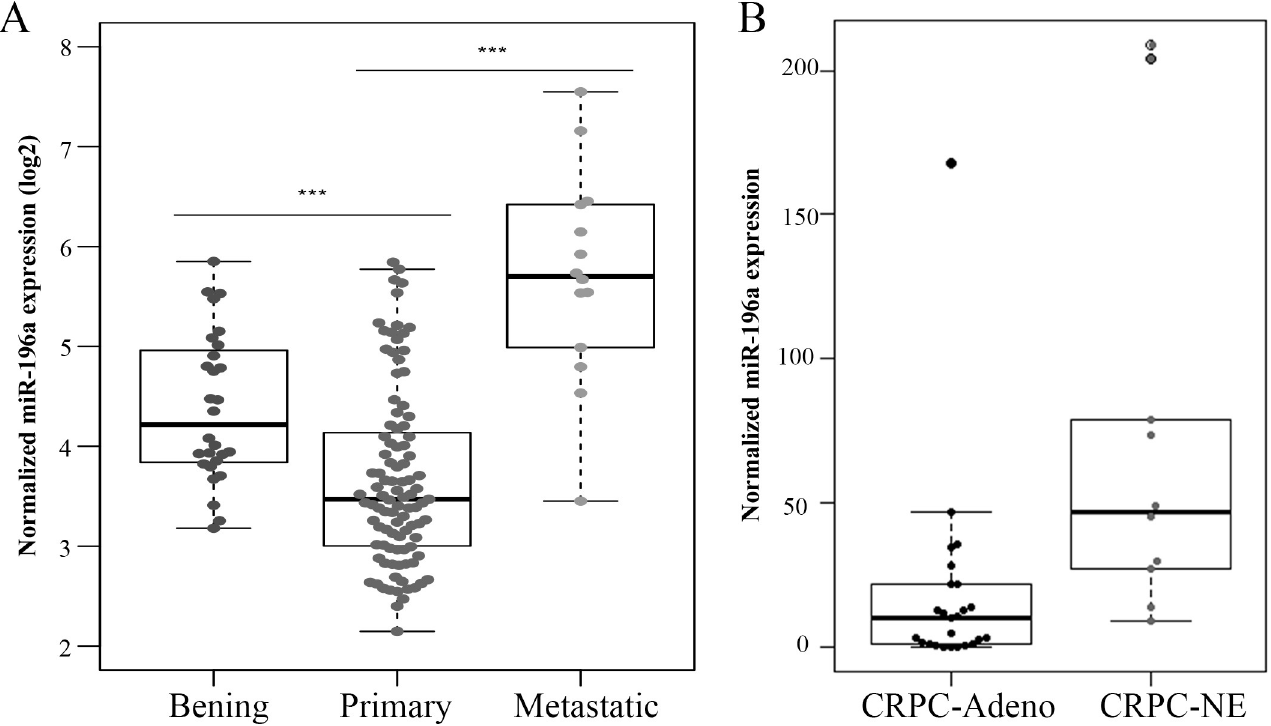
Fig 2. Boxplot graph of miR-196a expression in PCa samples. The publicly available dataset of prostate tissue samples, GSE21036, of miRNA expression in PCa tissues (A) and results recently published by Bhagirath et al. [29] (B) were used to generate these figures. A one-way ANOVA analysis between the groups and a post hoc multiple comparison test using Tukey were performed. Significance was set at p � 0.05 ( � ), p � 0.01 ( �� ) and p � 0.001 ( ��� ). CRPC-ADENO: Cohort of human metastatic castration-resistant prostate cancer (CRPC) clinical samples with no evidence of NED and patient-derived xenografts models with adenocarcinoma characteristics. CRPC-NE: Clinical samples from treatment-induced neuroendocrine (NE) prostate cancer and models of neuroendocrine prostate cancer.